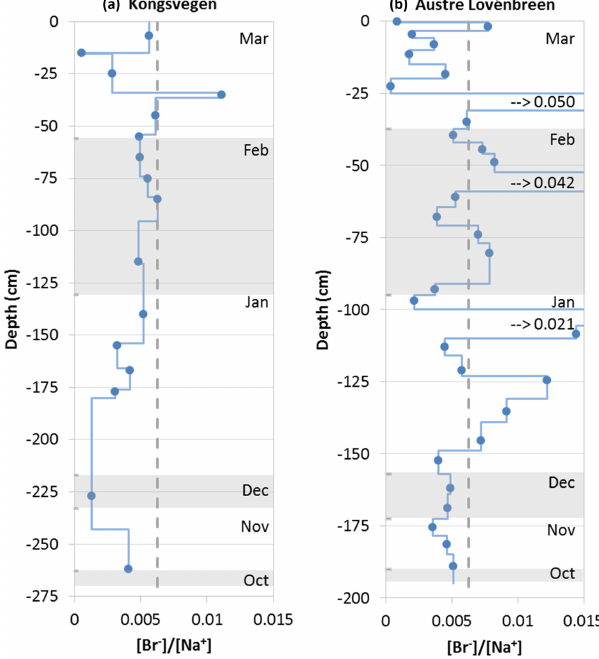
Figure 8. Bromide-to-sodium ratio in the snow pits KV (a) and AL (b) . Blue circles indicate observed ratios; blue lines corre- spond to ratios adjusted to the observed stratigraphy. The alternating shaded and non-shaded areas correspond from the top to the months March to October. The vertical dashed grey lines indicate the stan- dard seawater ratio. The values for three peaks in the snow pit AL beyond the range of the scale are